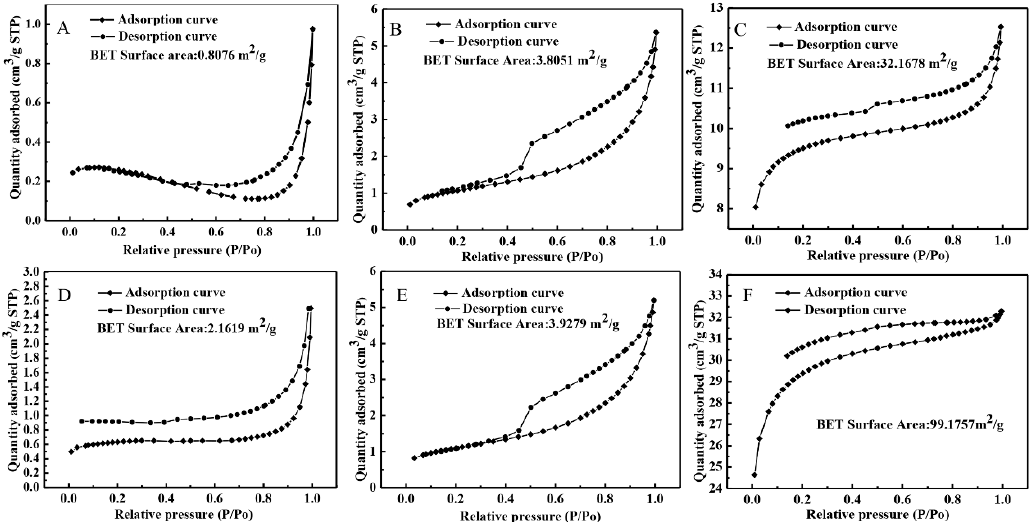
Figure 10. Specific surface area of samples. ( A ) Adsorption–desorption curve of the product from coal with a particle size greater than 0.9 mm without quenching by liquid nitrogen; ( B ) adsorption–desorption curve of the product from coal with a particle size between 0.5 and 0.9 mm without quenching by liquid nitrogen; ( C ) adsorption–desorption curve of the product from coal with a particle size between 0.1 and 0.5 mm without quenching by liquid nitrogen; ( D ) adsorption–desorption curve of the product from coal with a particle size greater than 0.9 mm with quenching by liquid nitrogen; ( E ) adsorption–desorption curve of the product from coal with a particle size between 0.5 and 0.9 mm with quenching by liquid nitrogen; ( F ) adsorption–desorption curve of the product from coal with a particle size between 0.1 and 0.5 mm with quenching by liquid nitrogen.